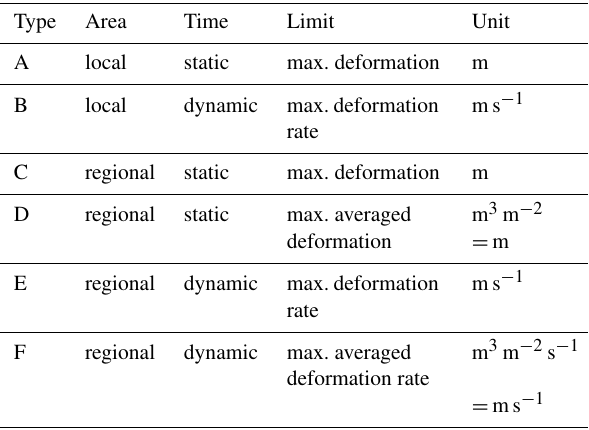
Table 1. Overview of subsidence threshold